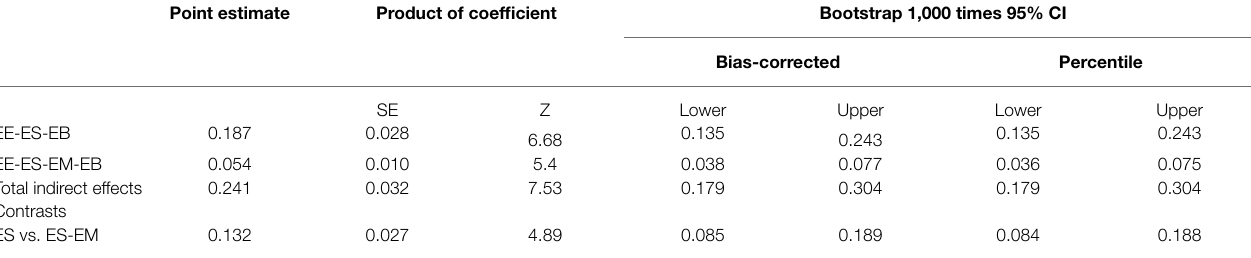
TABLE 6 | Analysis of the intermediary effects of the